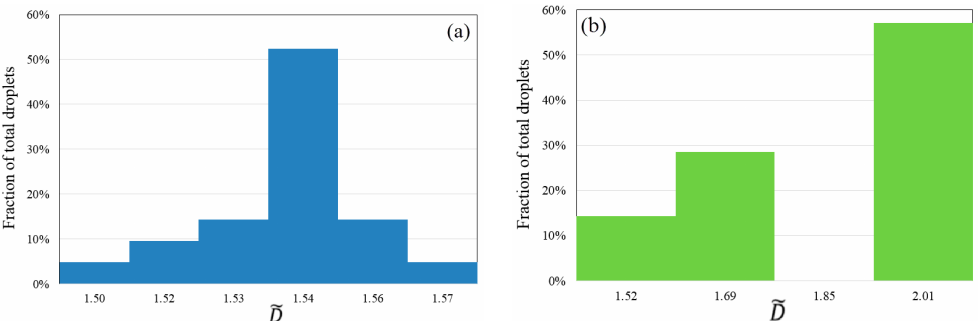
Figure 6. ( a ) Histogram of size distribution of 22 droplets generated in three circumferentially aligned channels before occurrence of merging and ( b ) histogram of size distribution of 7 droplets formed from merging, when Ω = 150 rad/s and Bo = 0.08. The droplet size is non-dimensionalized by hydraulic diameter of microchannel.